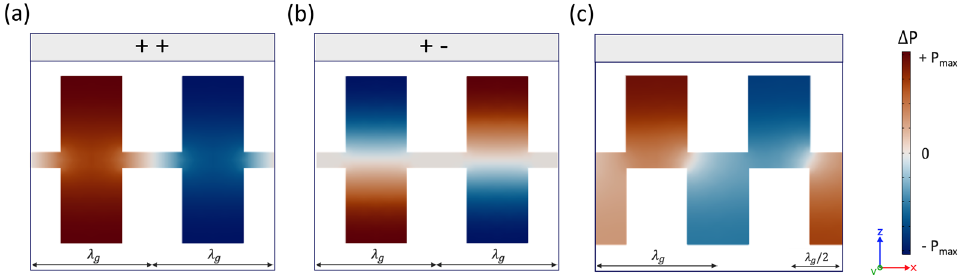
Figure 2. ( a,b,c ) Instantaneous pressure fields (cid:31) P (with (cid:31) P = | P − P 0 | , where P 0 is the background pressure field) of eigenmodes calculated using loss-inclusive FEM simulations. Plots show a xz-slice through the centre of the sample ( a /2) along the direction of propagation (x axis). White areas indicate the acoustically rigid aluminium substrate, separated in the z axis. ( a ) The fundamental, or symmetric mode (labelled ++) of the mirror symmetry system at the 1st BZB ( k (cid:31) = π/ (cid:31) p ). ( b ) The anti-symmetric mode (labelled +-) of the mirror symmetry system taken at the 1st BZB ( k (cid:31) = π/ (cid:31) p ). ( c ) The degenerate mode of the glide symmetry system at k (cid:31) 1 = 423 m − .